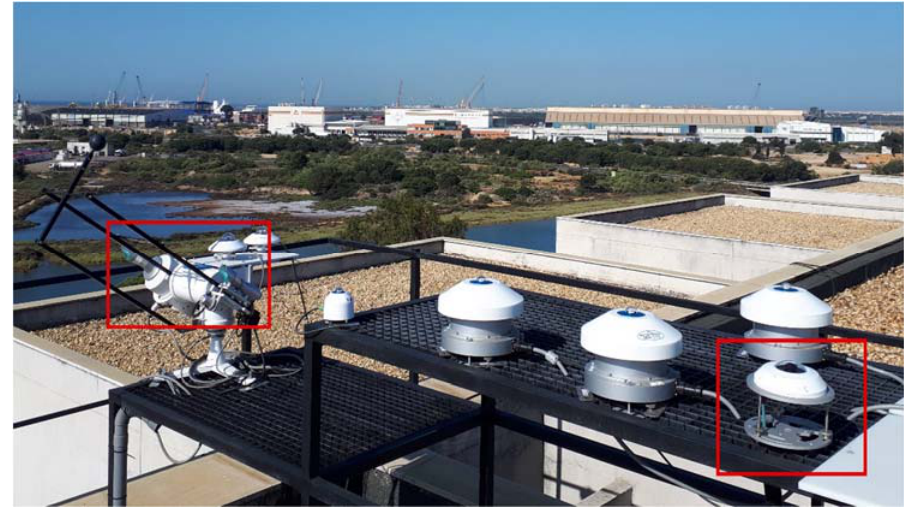
Figure 3. Radiometric and meteorological station of the Universidad de Huelva at the La Rábida Campus. The spectroradiometer and the pyrheliometer (at the left) and the all-sky imager (at the right) are marked with red rectangles.